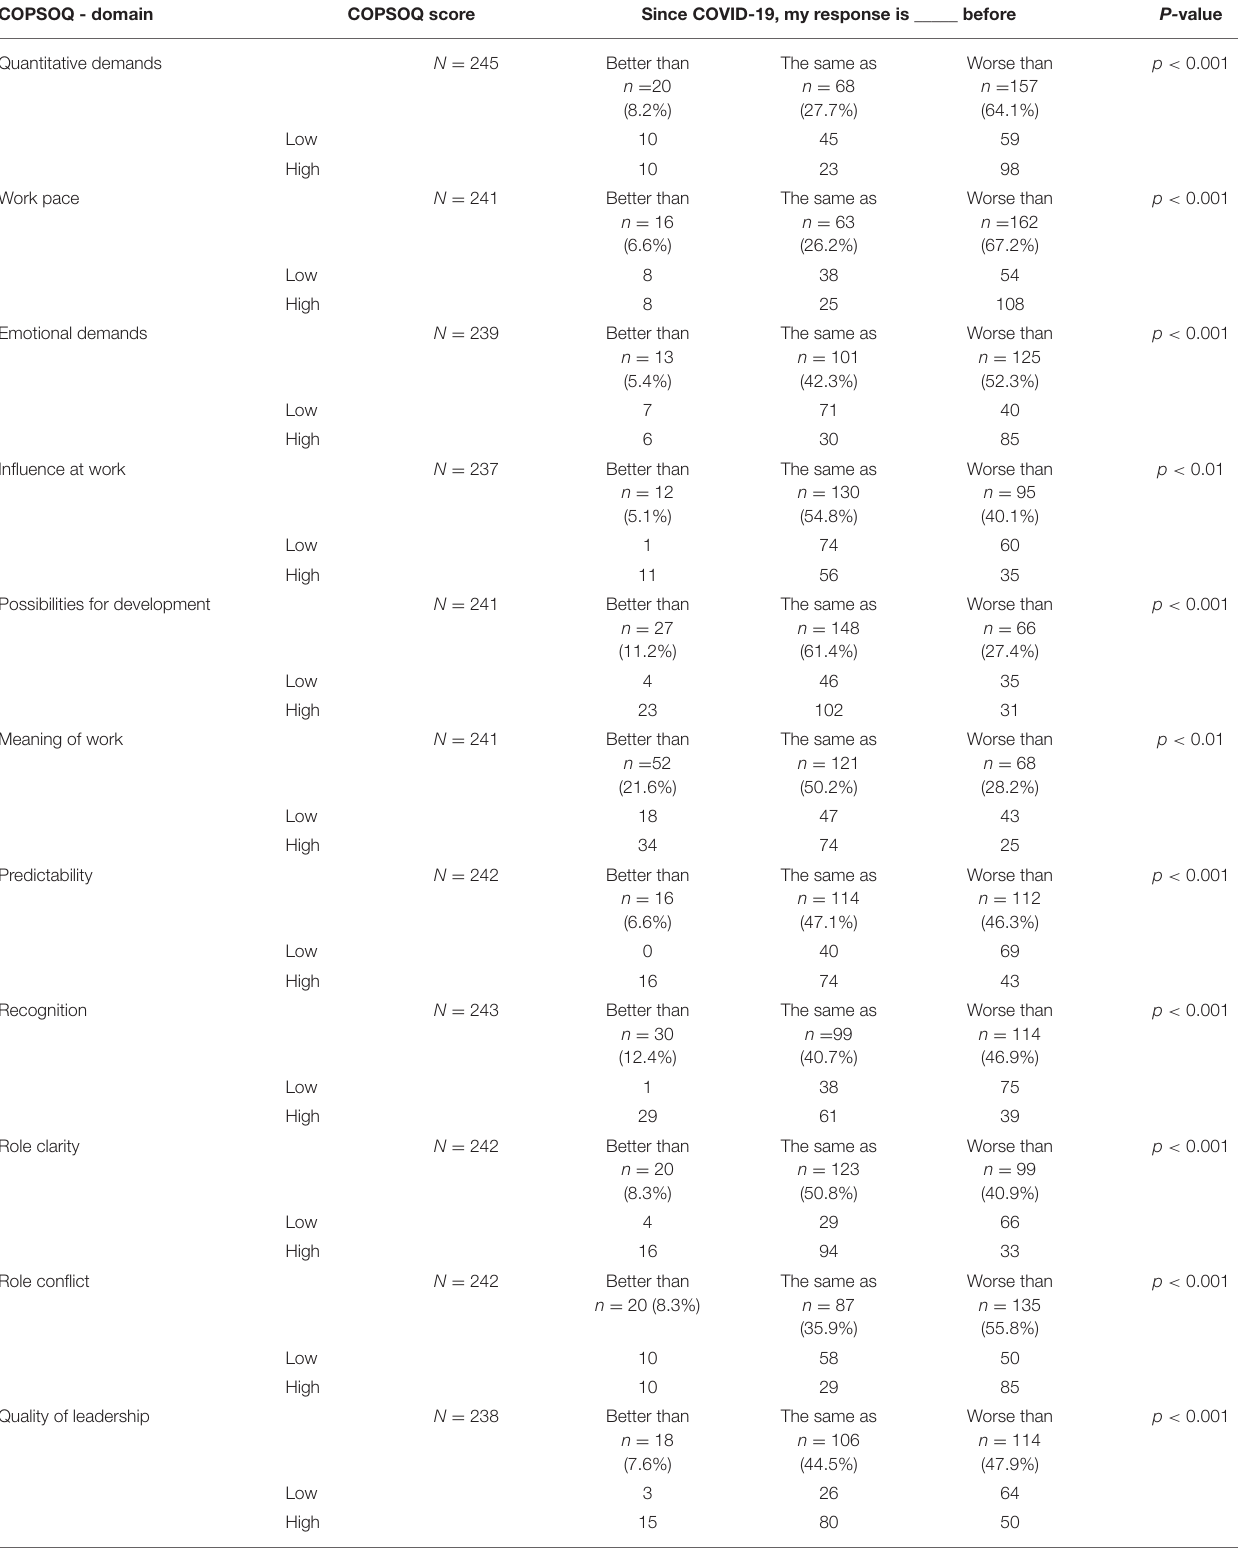
TABLE 5 | Cross-tabulation of COPSOQ-III scores and COVID-19 (technicians). COPSOQ -